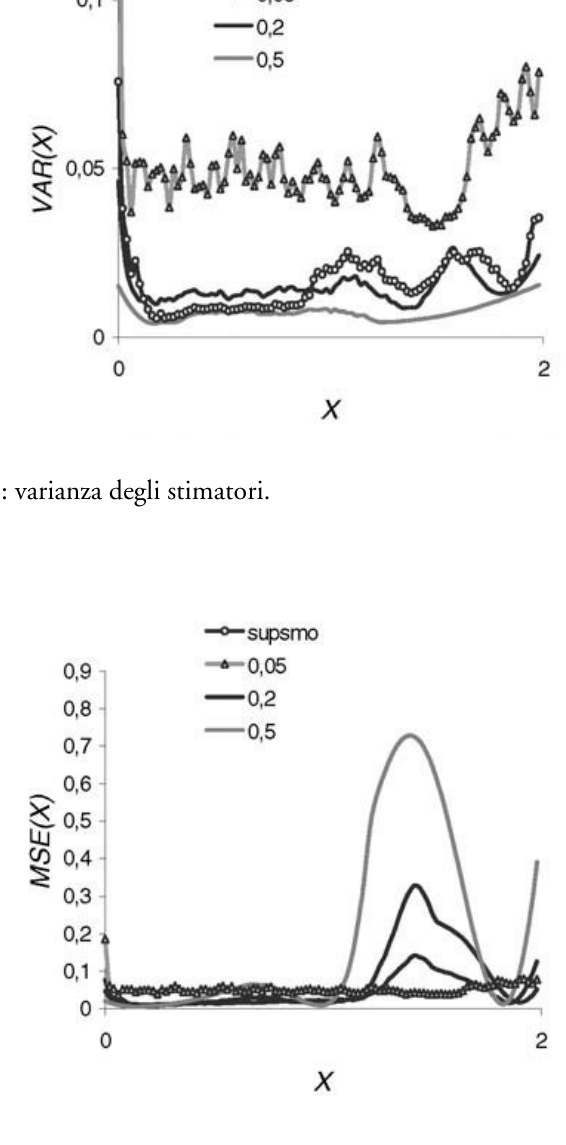
Figura 8 – Modello II: errore quadratico medio degli